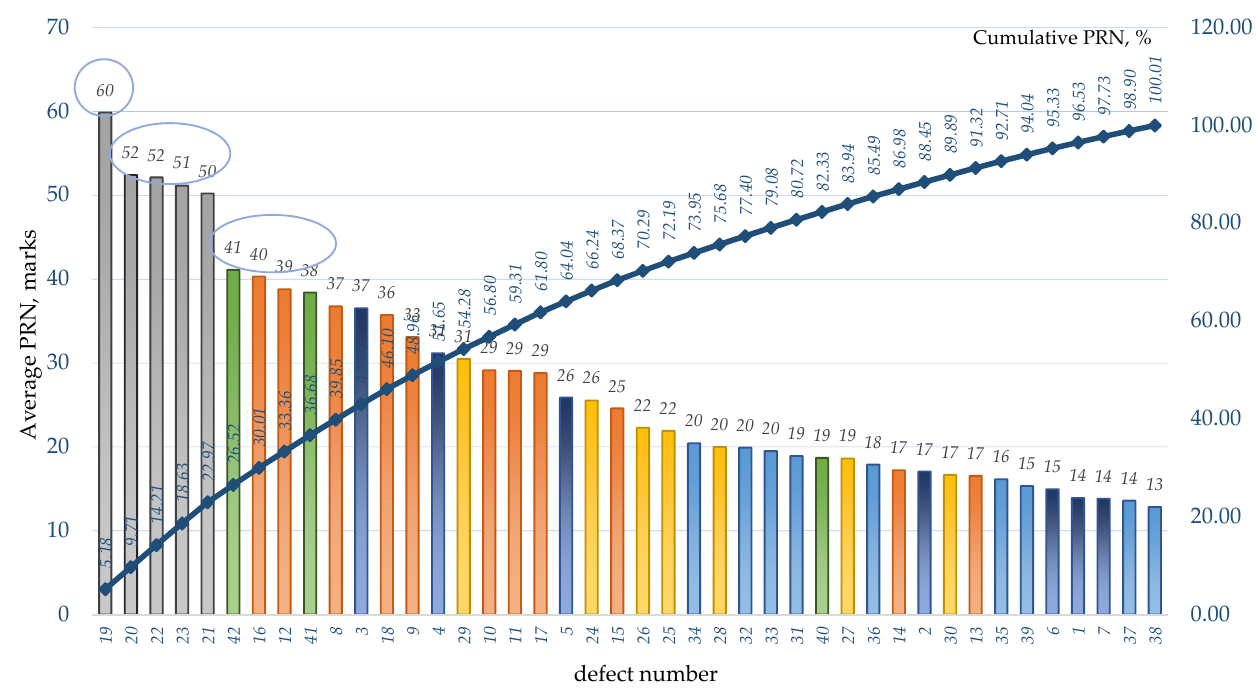
Figure 6. PRN average value analysis by the Pareto method.